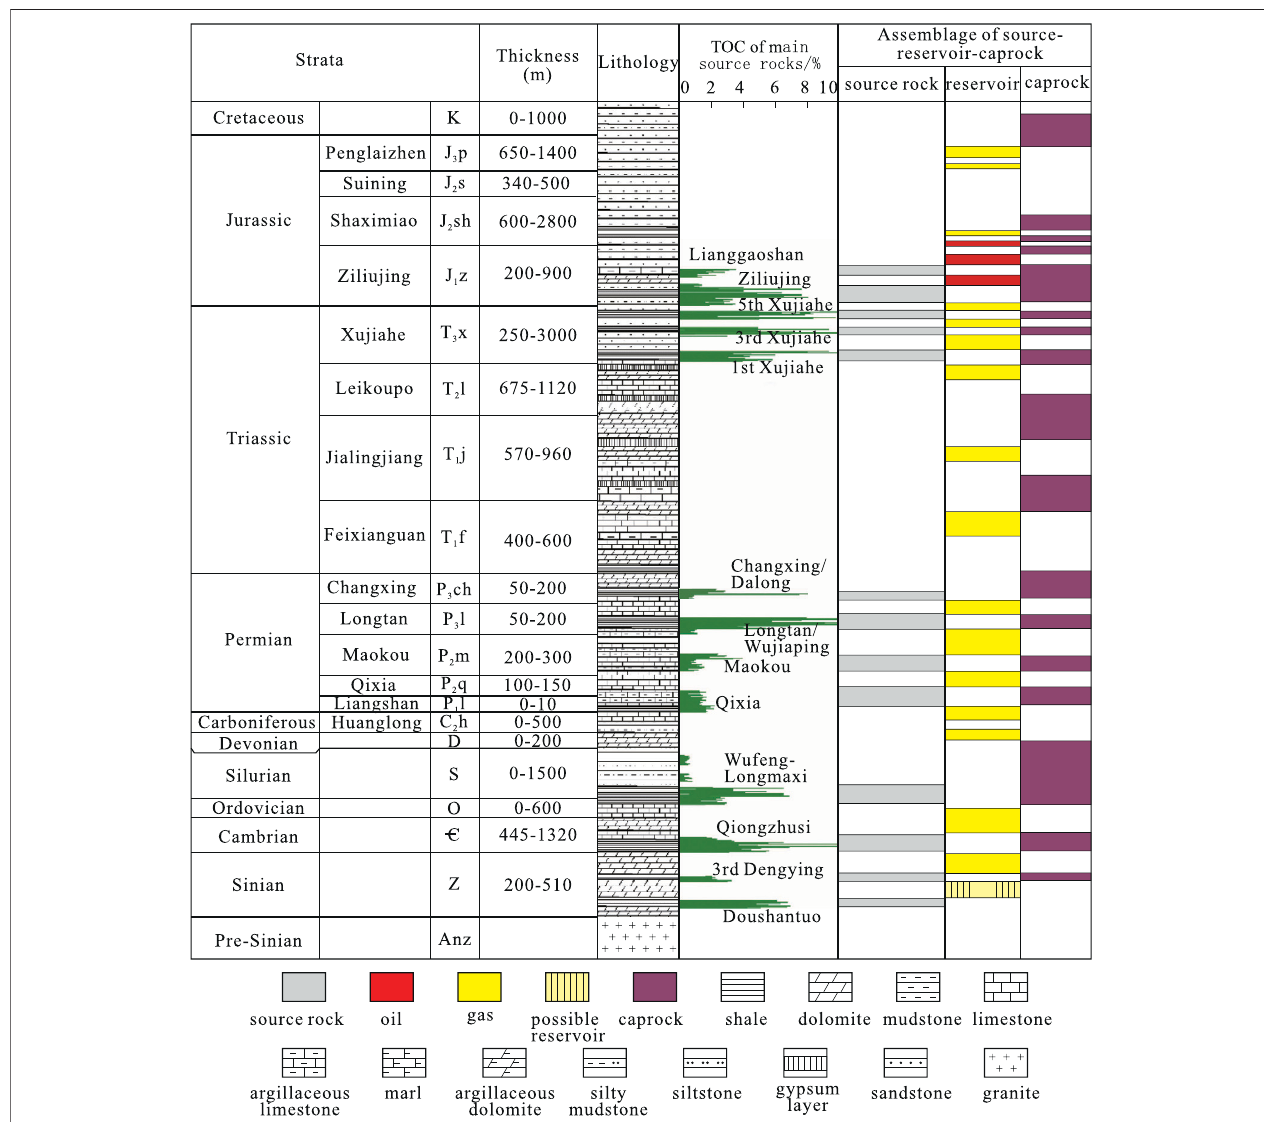
FIGURE2| Generalized stratigraphy oftheSichuan basin. Also shown are theTOCofmain source rocks and thesource-reservoir-caprock assemblage.Modi fi ed from Dai et al. (2021).